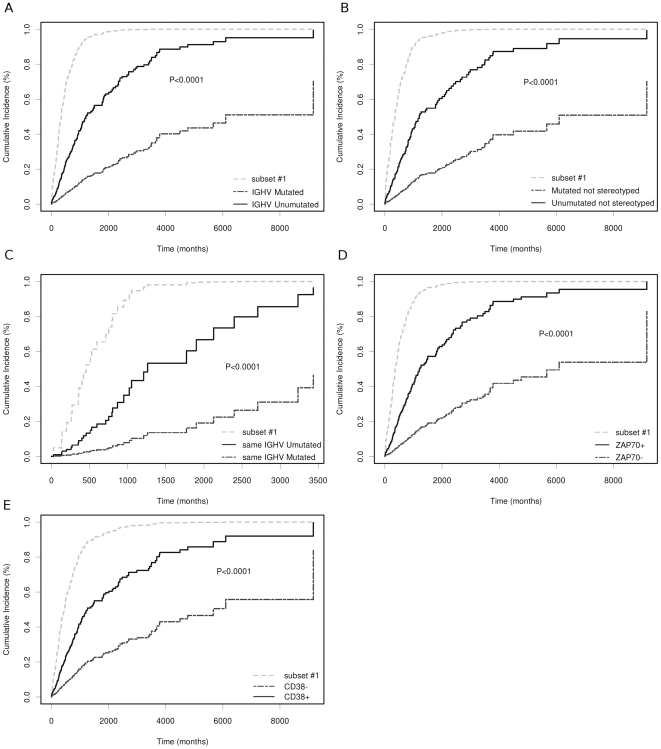
TTFT analysis of subset #1.
A: Subset #1 patients compared with all UM and M patients. B: Subset #1 compared with all non-stereotyped UM and non-stereotyped M patients. C: Subset #1 compared with all UM and M patients showing the same IGHV usage of subset #1. D and E: Subset #1 patients compared with the remaining cases grouped according to ZAP-70 and CD38 expression positivity, respectively.